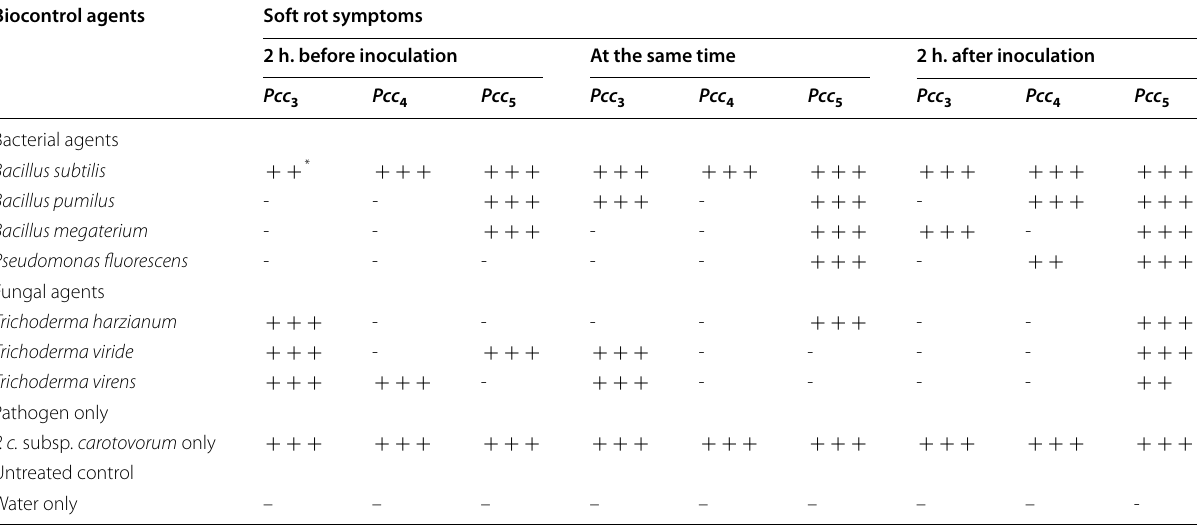
Table 4 Inhibitory activity of the crude cultural filtrates of biocontrol agents against Pectobacterium carotovorum subsp. Carotovorum strains, when artificially inoculated on potato tuber slices, in vivo tests